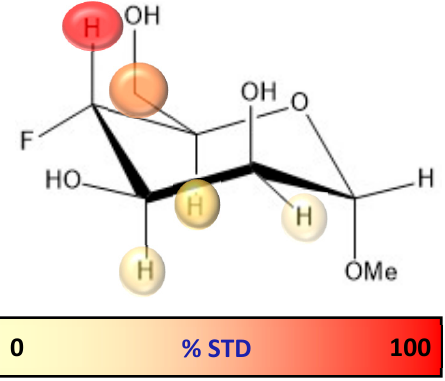
Figure 9. Relative STD profile for α -OMe-4-F-Man (5 mM) in the presence of DC-SIGN (65 uM, ligand / lectin ratio is 77 / 1), normalized to that of the H-4 proton (100% relative STD).